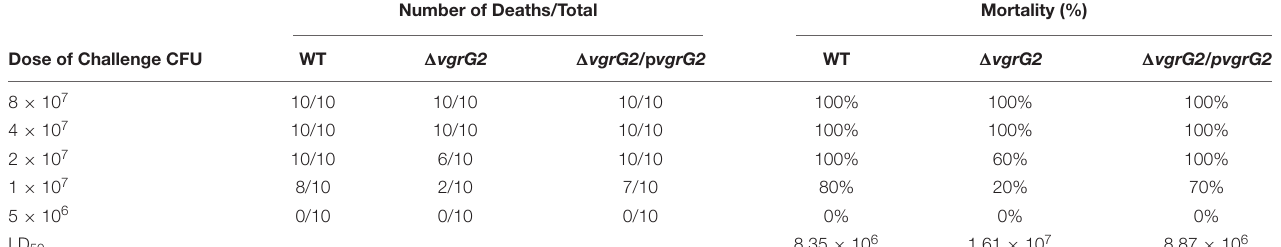
results of the mutant and complemented strains related to six antibiotics were consistent with those of BPM, as shown in Supplementary Table 1 . All of these strains were sensitive